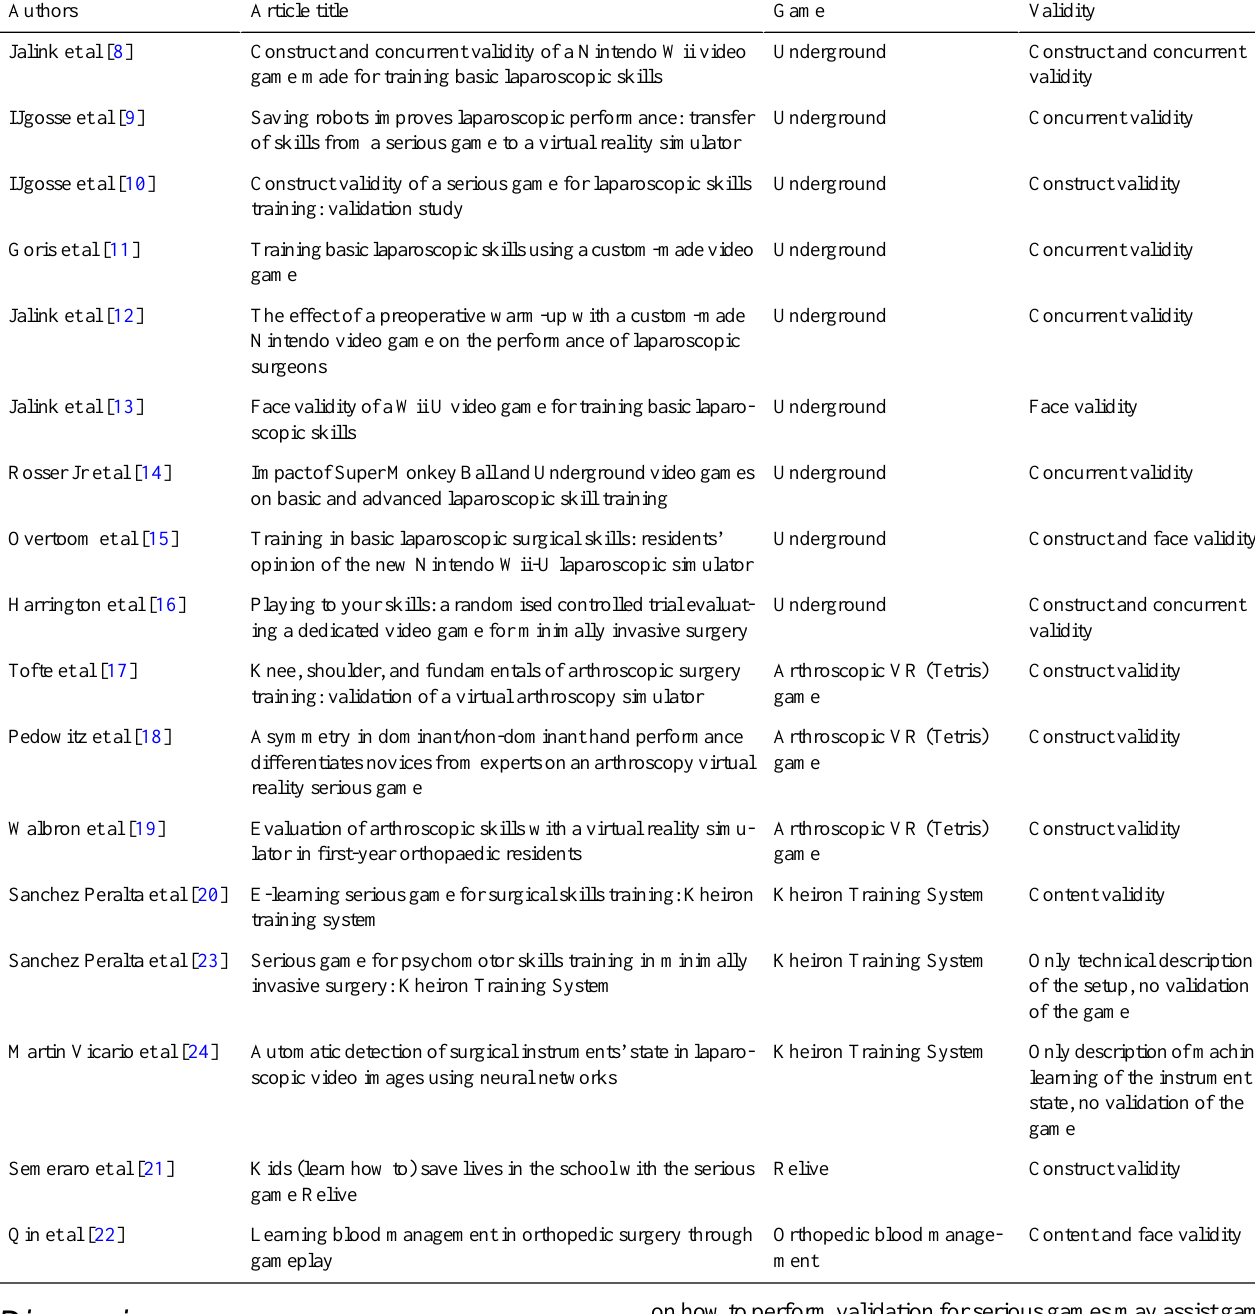
Table 1. Articles included in the review.